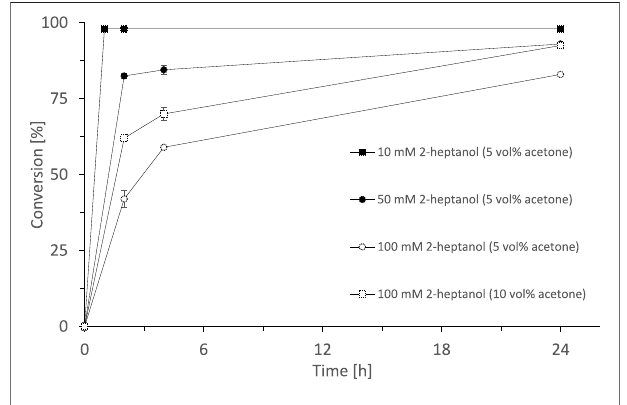
FIGURE 2 | Sy ADH catalysed oxidation of rac -heptan-2-ol (10, 50 and 100 mM) employing acetone as cosubstrate. Reaction conditions: [ rac - heptan-2-ol] = 10 – 100 mM, [acetone] = 5 or 10% v/v, [NADP + ] = 1 mM, [ E.coli C43(DE3) pET24b- syadh ] =10 mg× mL − 1 , [KPi,pH 7] = 50 mM, total volume: 500 μ L, T = 30 ° C, 600 rpm. Data are expressed as the mean ± SD of the two independent experiments performed in technical duplicates.